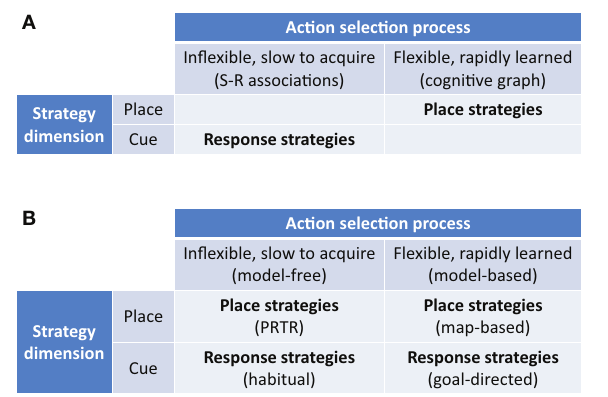
FIGURE 2 | New taxonomy of navigation strategies based on model-based/model-free reinforcement learning. (A) Previous taxonomies highlight the distinction between flexible rapidly acquired map-based strategies and inflexible slowly acquired S-R strategies. (B) New taxonomy highlighting model-free and model-based place strategies as well as model-free and model-based response strategies. PRTR, place-recognition triggered response strategies as classified by Trullier et al. (1997).